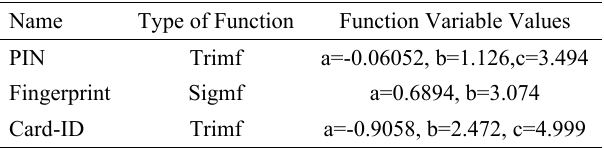
Table 6: Fuzzification functions and variable values